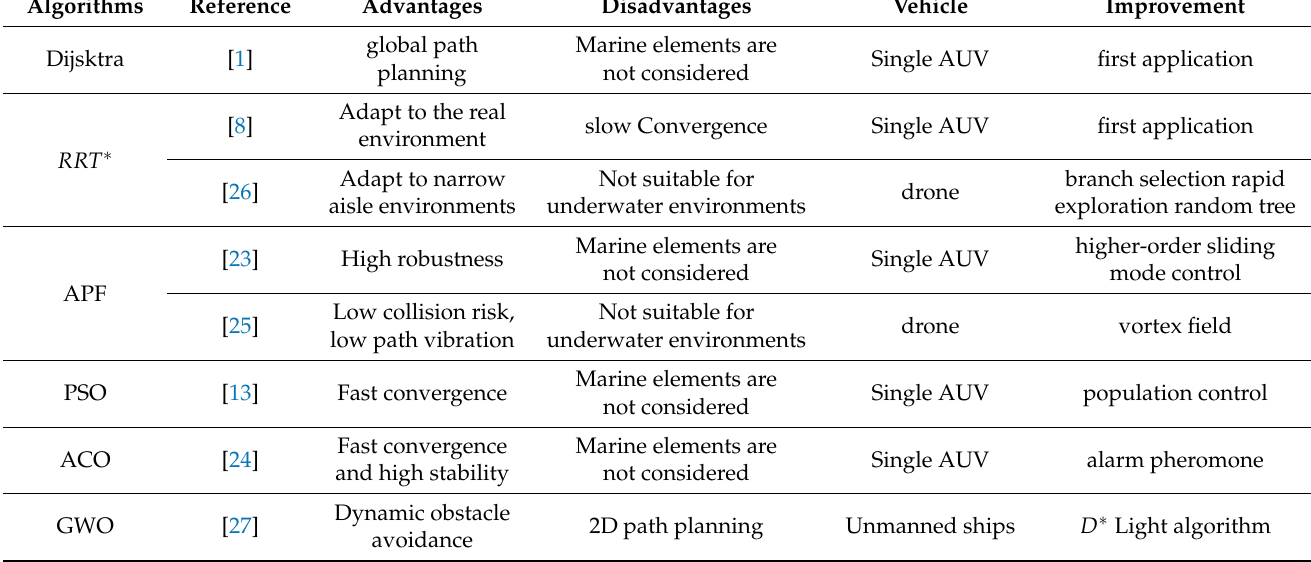
Table 1. Algorithm Comparison Summary.